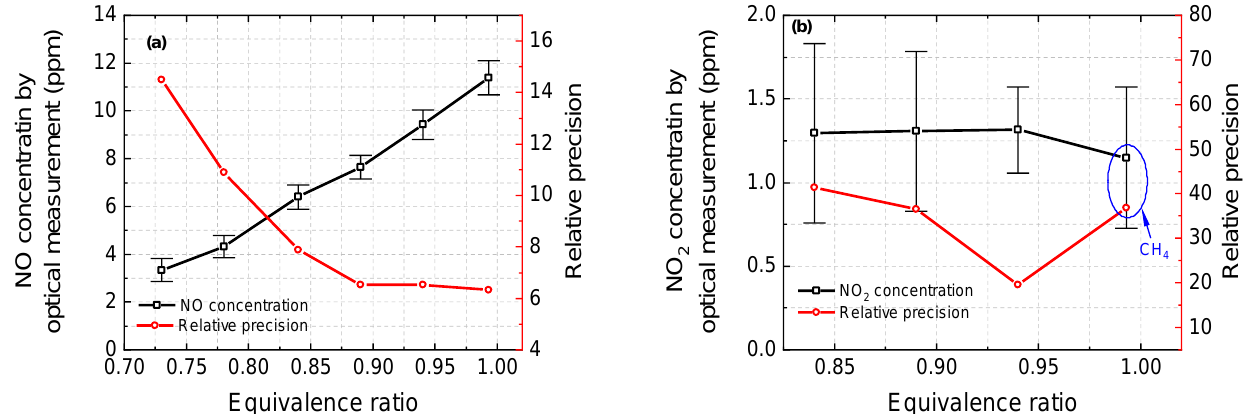
Figure 13. Measured NO ( a ) and NO 2 ( b ) concentrations and relative precision varying with the equivalence ratio in combustion gases.